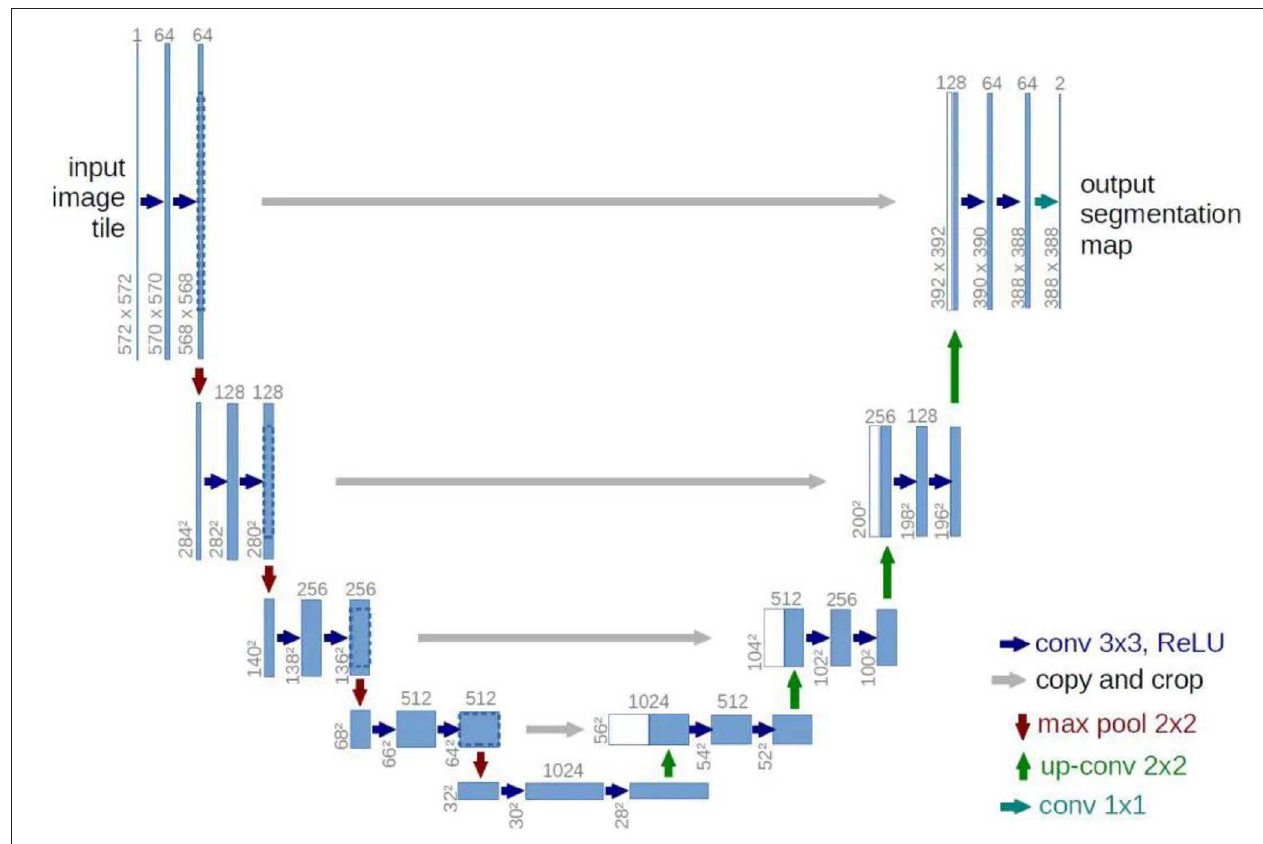
FIGURE 2 | U-Net model: classical symmetric codec structure with feature concatenate.